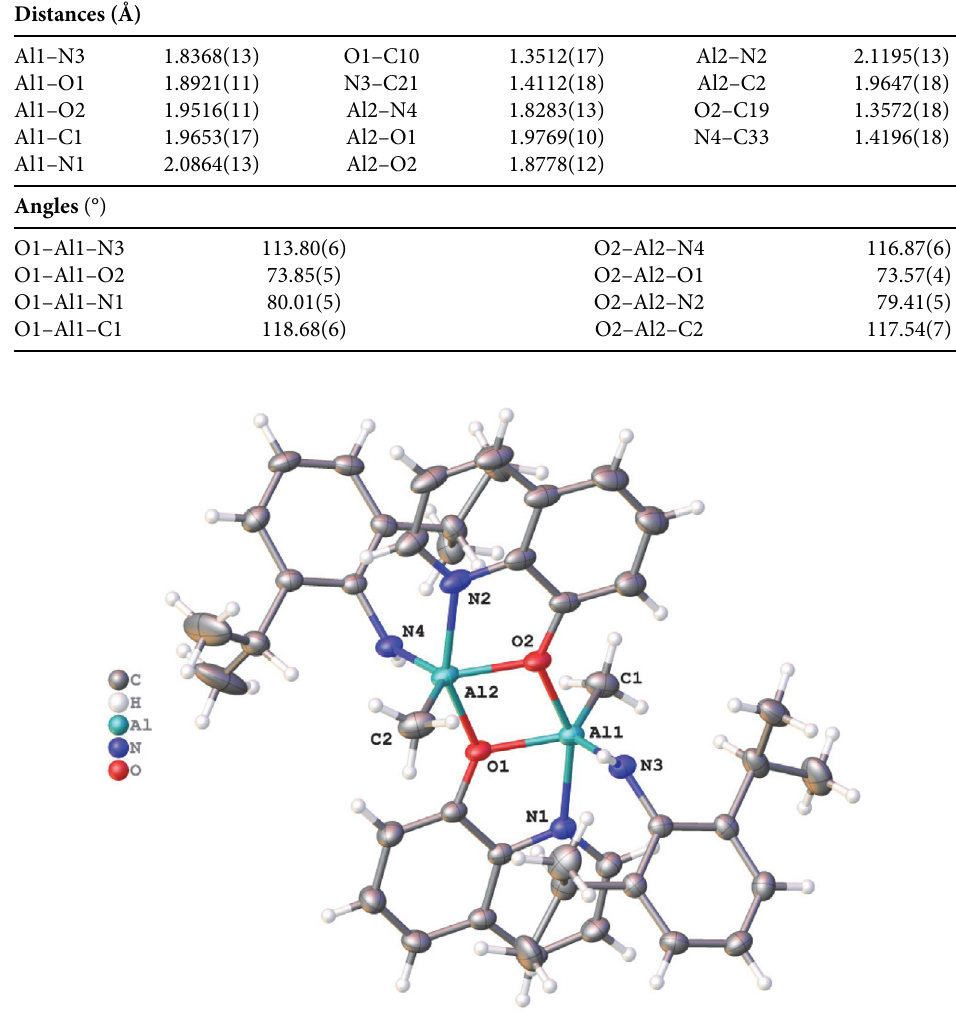
Table 2. Selected interatomic distances and angles of 2 ∙ THF